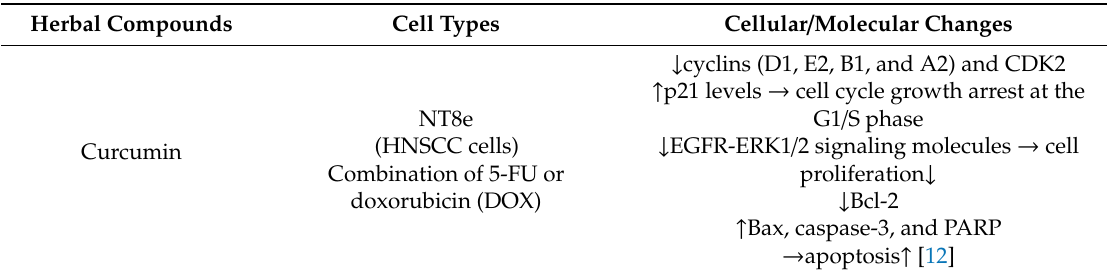
Table 1. Regulatory E ff ects of Traditional Herbal Medicine (THM) compounds for Head and Neck Squamous Cell carcinoma (HNSCC) Cell Growth /